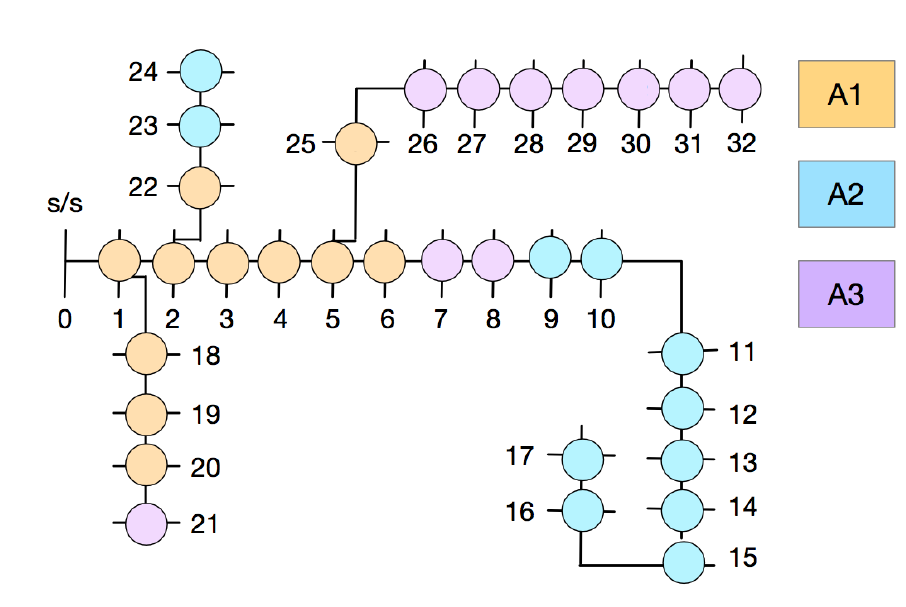
Figure 6. The 33-bus test system and corresponding regions of the aggregators adapted with permission from